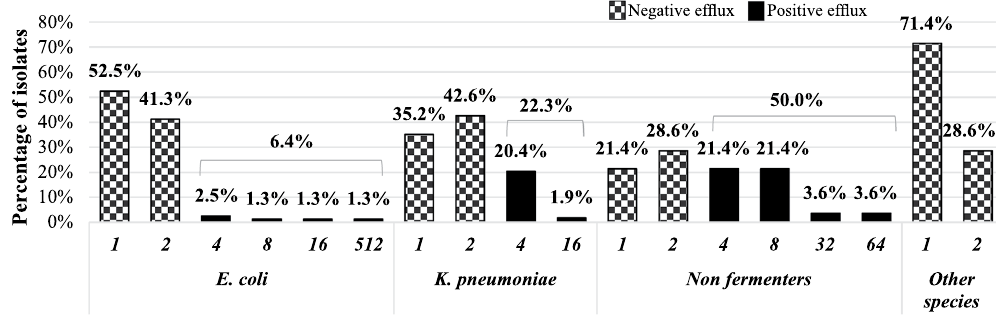
Figure 1. CIP MDF values and prevalence of isolates showing active efflux activity among various species. CIP MDF, ciprofloxacin MIC decrease factor; other species, other Enterobacteriaceae including: C. freundii , E. aerogenes , E. cloaceae , K. oxytoca and P. mirabilis ; non-fermenters, A. baumannii and P. aeruginosa . Isolates of CIP MDF ≥ 4 are considered to have active efflux